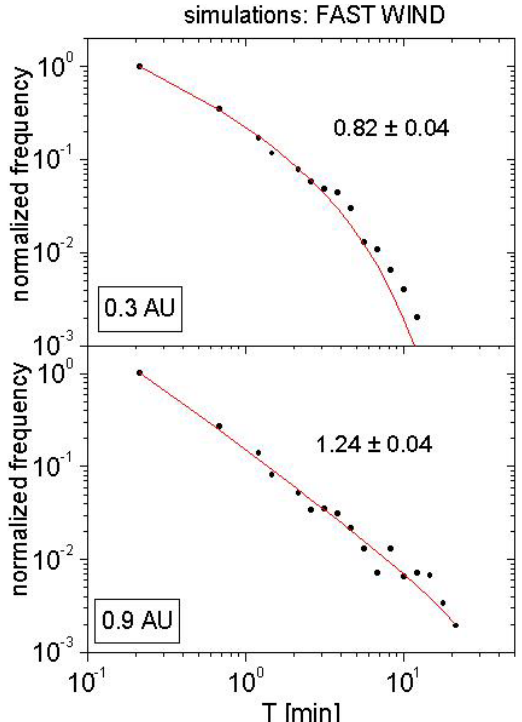
Fig. 6. Fast wind numerical simulation: waiting-time distributions as a function of radial distance. The points are derived from an aver- age of the histogram over logarithmically, equally spaced intervals and are normalized to the maximum